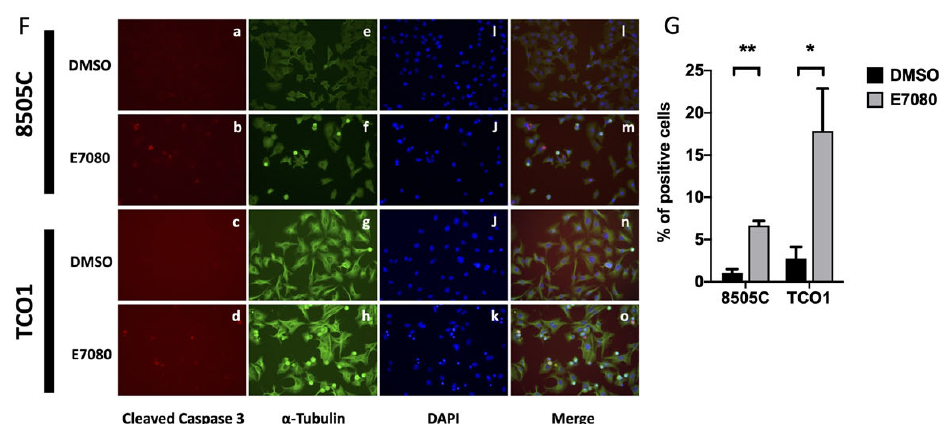
Figure 1. The antitumor effect of lenvatinib (E7080) monotherapy in an in vitro model. ( A ) Im- munofluorescence analysis of 8505C and TCO1 human ATC cells confirmed the expression of FGFR1 (panels a,j green), PDGFR β (panels b,k green), and VEGFR2 (panels c,l green). DAPI (panels d–f, m–o blue) was used for nuclear staining. They were merged and are shown in panels g – i, p – r. ( B ) Effects of different concentrations of lenvatinib on cell viability. ( C ) Western blot showing phos- phorylation of AKT and ERK in 8505C or TCO1 cells with 1 to 50 µ M E7080 for 24 h or DMSO as control. ( D , E ) The band density was quantified and compared among different doses. ( F ) Cleaved caspase 3 level was confirmed by immunofluorescence assay on 8505C and TCO1 cells treated with 50 µ M lenvatinib for 24 h or with DMSO as control (panels a – d ). α -Tubulin and DAPI are shown in green (panels e–h ) and blue (panels i – k ), respectively. They were merged and are shown in panels l – o , indicating the presence of cleaved caspase 3 in the nuclei of 8505C and TCO1 cells. ( G ) Quantification of cleaved caspase 3-positive cells. 8505 and TCO1 cells treated with 50 µ M lenvatinib for 24 h had significantly higher counts of cleaved caspase 3-positive cells than cells treated with DMSO. * p < 0.05, ** p <